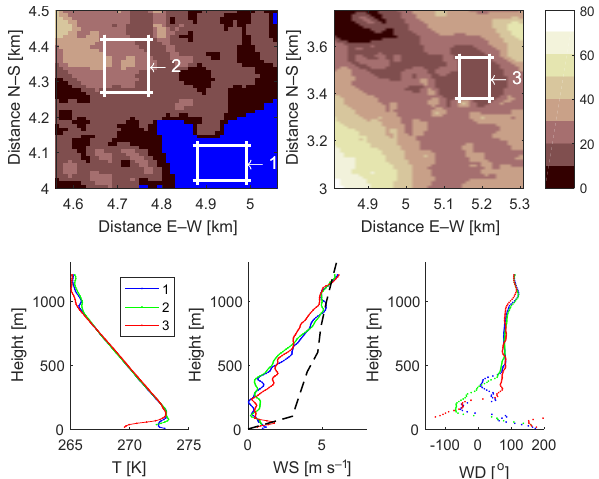
Figure 6. Same as Fig. 4 but for case 0 with Neumann BC and neutral